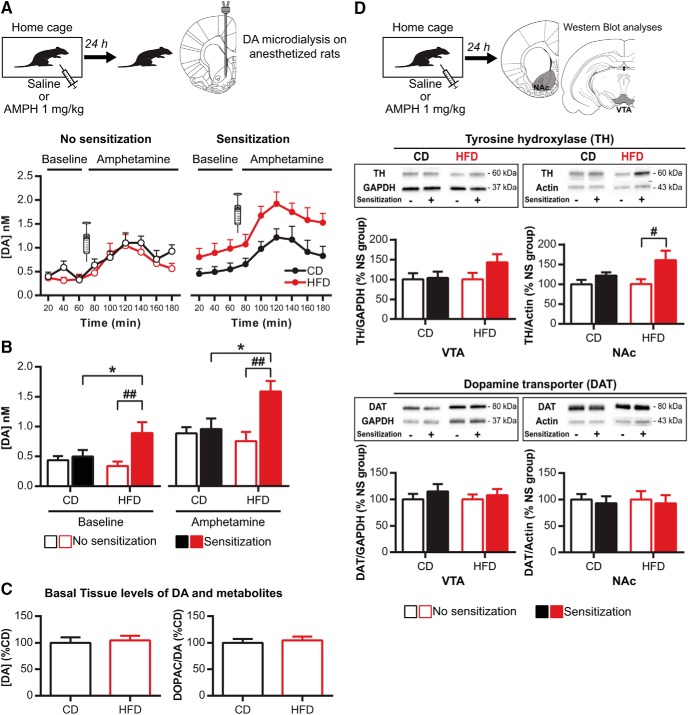
Amphetamine sensitization increases DA release and TH expression in the NAc after pHFD. A, pHFD rats showed an increase in NAc DA release after amphetamine sensitization but not before (no sensitization CD n = 6 and pHFD n = 9; sensitization CD n = 9 and pHFD n = 8). Syringes represent the time of amphetamine injection. B, Amphetamine sensitization increased NAc DA release only in pHFD group at both basal state and in response to a second injection of amphetamine. C, Basal tissue levels of DA (left) and DOPAC-to-DA ratio (right) in the NAc was not altered by pHFD in nonsensitized rats (data are expressed in % of CD; CD n = 10 and pHFD n = 17). D, Amphetamine sensitization increased expression of TH in the NAc and the VTA but did not affect DAT expression (data are expressed in % of respective nonsensitized group; no sensitization CD n = 11 and pHFD n = 10; sensitization CD n = 11 and pHFD n = 11). Data are expressed as mean + SEM. *p < 0.05 diet effect; #p < 0.05, ##p < 0.01 sensitization effect.